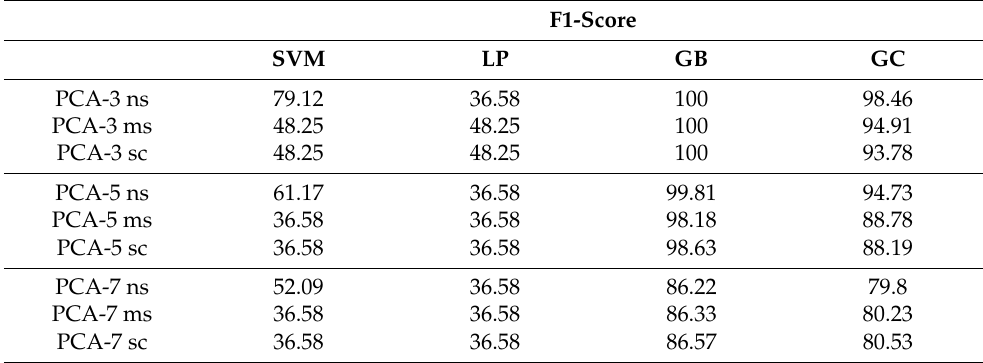
Table 4. The F1 score for classification of HSI2 image 2 using PCA 3, 5, and 7 bands and the different scaling and normalization methods using the four machines.